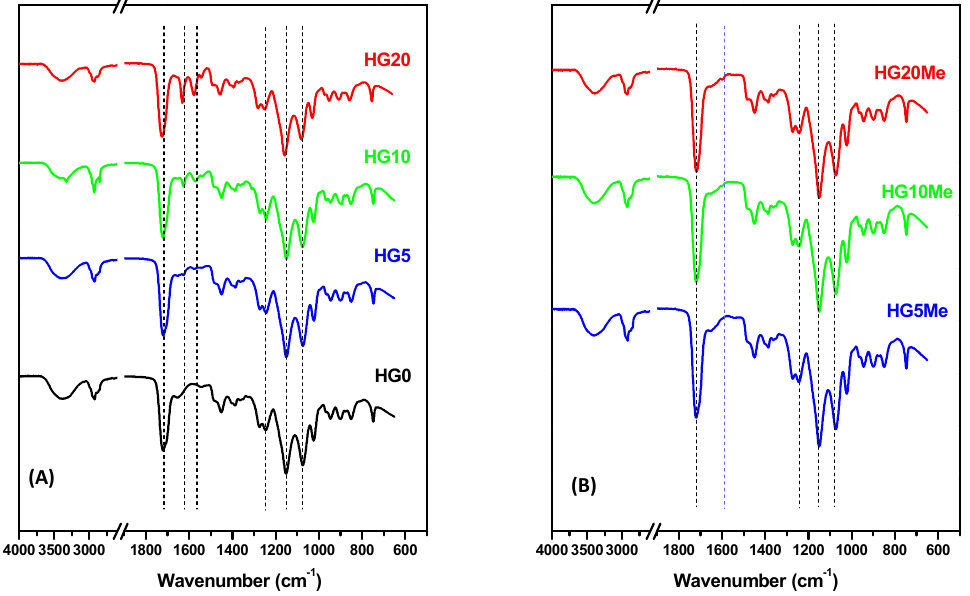
Figure 2. Attenuated total reflectance Fourier Transformation infrared spectroscopy (ATR − FTIR) spectra of ( A ) unmodified and ( B ) methylated hydrogels.